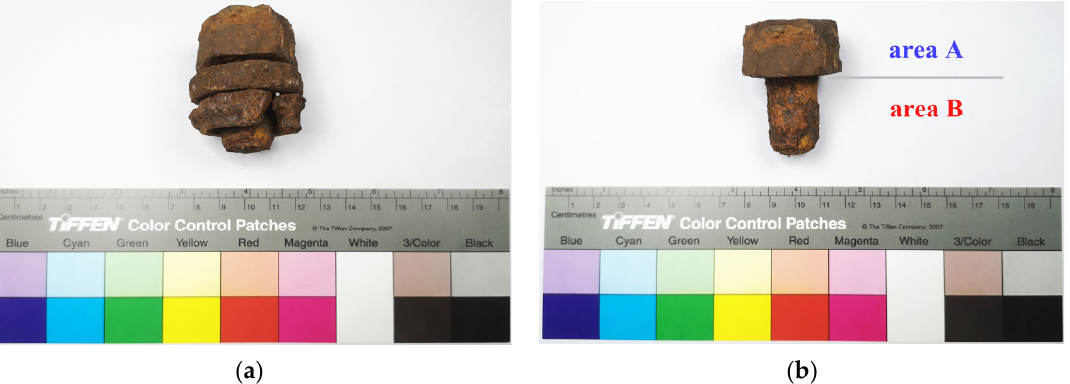
Figure 17. Archaeological steel screw from Lingzhao Xuan of the Qing Dynasty in the Forbidden City. Original state ( a ); After separation ( b ).